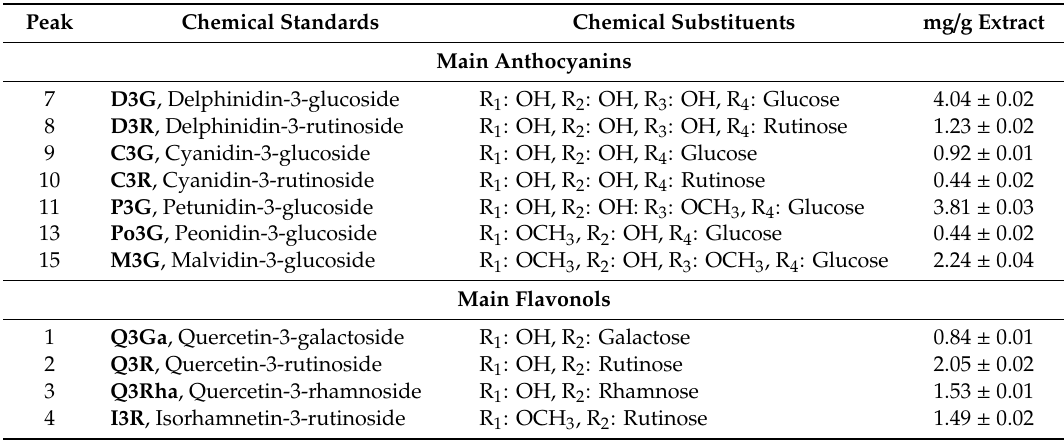
Table 2. Major flavonoids quantified by high-performance liquid chromatography with diode array detection (HPLC-DAD) in Calafate hydroalcoholic extract.